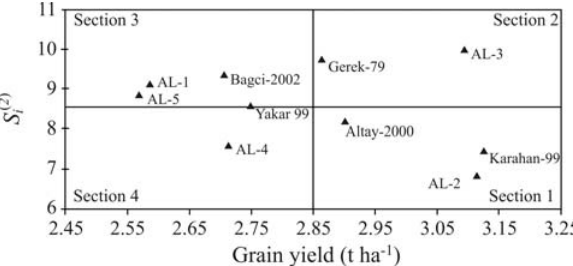
Figure 2 - Plot of the variance between the ranks over environments ( Si ( 2 ) ) against mean grain yield ( gy , t ha -1 ) for 10 bread wheat genotypes over en-